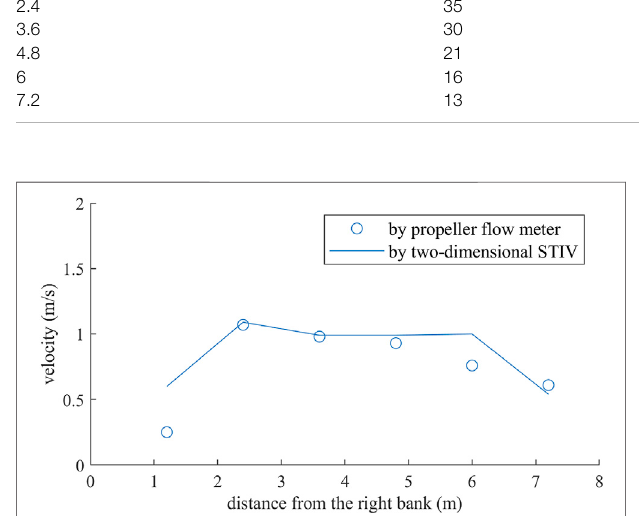
Velocity by 2D STIV (m/s)